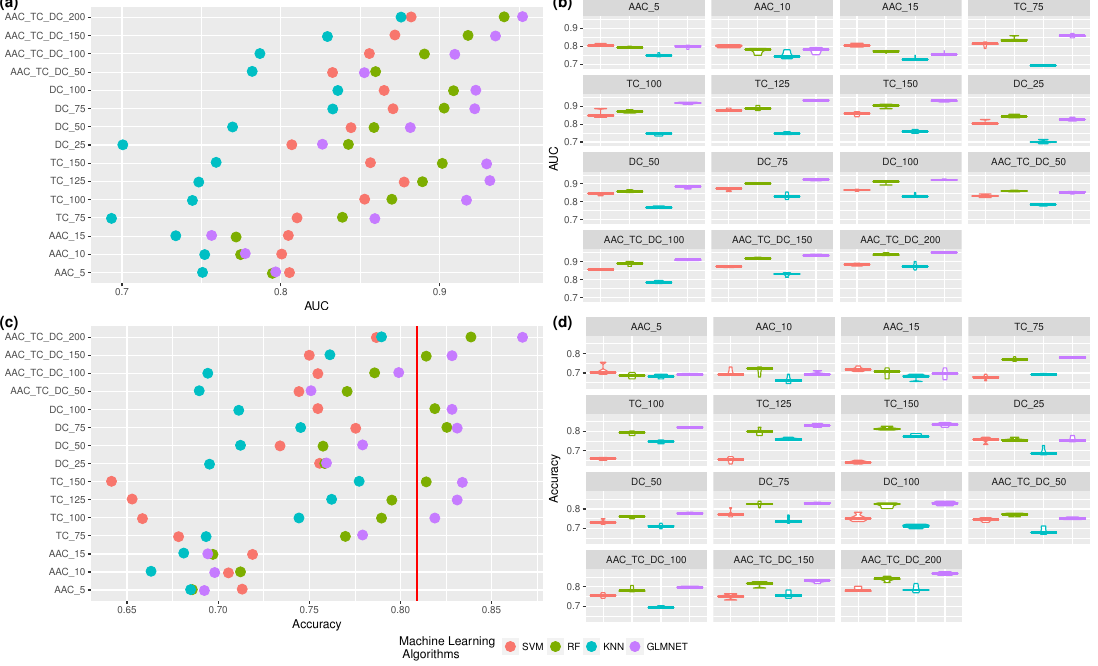
Figure 1. Results obtained in the feature selection process. ( a ) Performance using AUC, ( b ) boxplot using AUC, ( c ) performance using accuracy, and ( d ) boxplot using accuracy. Best previously published value in the literature by Ramaprasad et al. [2] (red